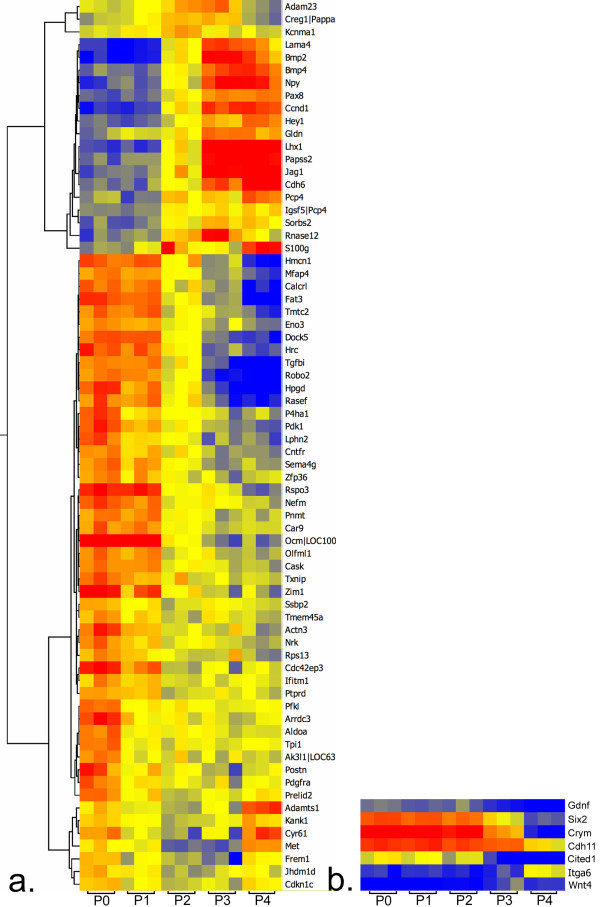
Heatmap of genes showing significant changes in levels of expression between the progenitor mesenchyme at birth and the mesenchyme at day 2 of life. Fifteen microarrays, three daily from birth (P0) to post-natal day 4 (P4), were used to define the progression of gene expression in the mouse kidney beginning with the multi-potential progenitor mesenchyme and continuing through induced mesenchyme to early renal vesicles. a) The expression level of twenty genes increased between P0 and P2, whereas the level decreased for fifty genes (blue signifies low, yellow intermediate, and red high levels of expression). The pattern over the entire 4-day period is shown with each column representing the expression levels of a single microarray. Hierarchical clustering divides the genes into groups with similar expression patterns. For example, three genes, Tpi1, Aldoa, and Pfkl, are part of a cluster towards the bottom of the figure. Their levels of expression decreased early, decreasing by P1, and then remained stable through P4. Other clusters of genes with decreasing levels show a continued decrease, or did not demonstrate a decrease until P2. b) For comparison, the heatmap shows the pattern of expression of genes commonly identified with capping mesenchyme. The patterns illustrate changing levels of expression later in the course after birth.